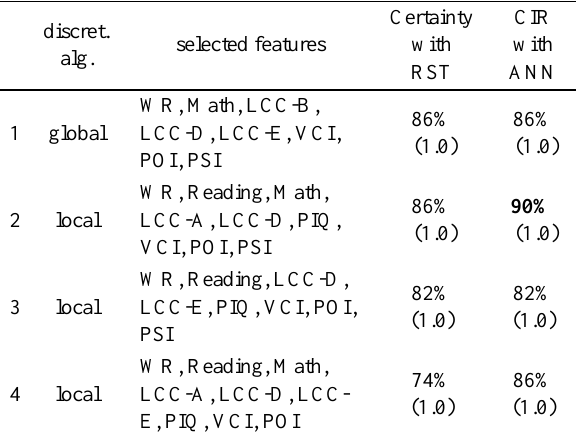
Table 6. Selected feature sets and their corresponding best certainty/CIR with data set A. (The number within parenthesis represents the coverage of the prediction.)